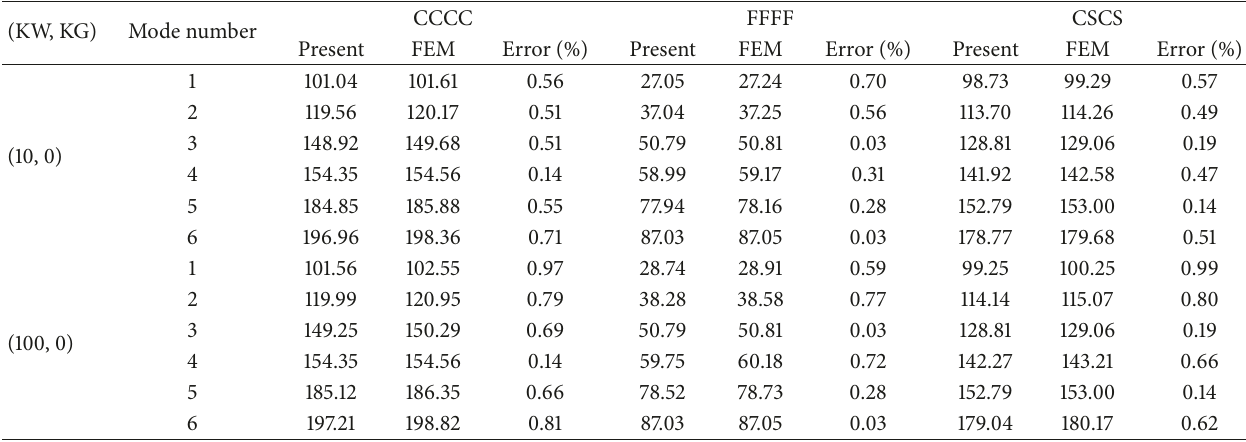
Table 13: Comparison of frequency parameters Ω for Type 1-1 (1-0-0) annular sector plates on Winkler foundations with various boundary